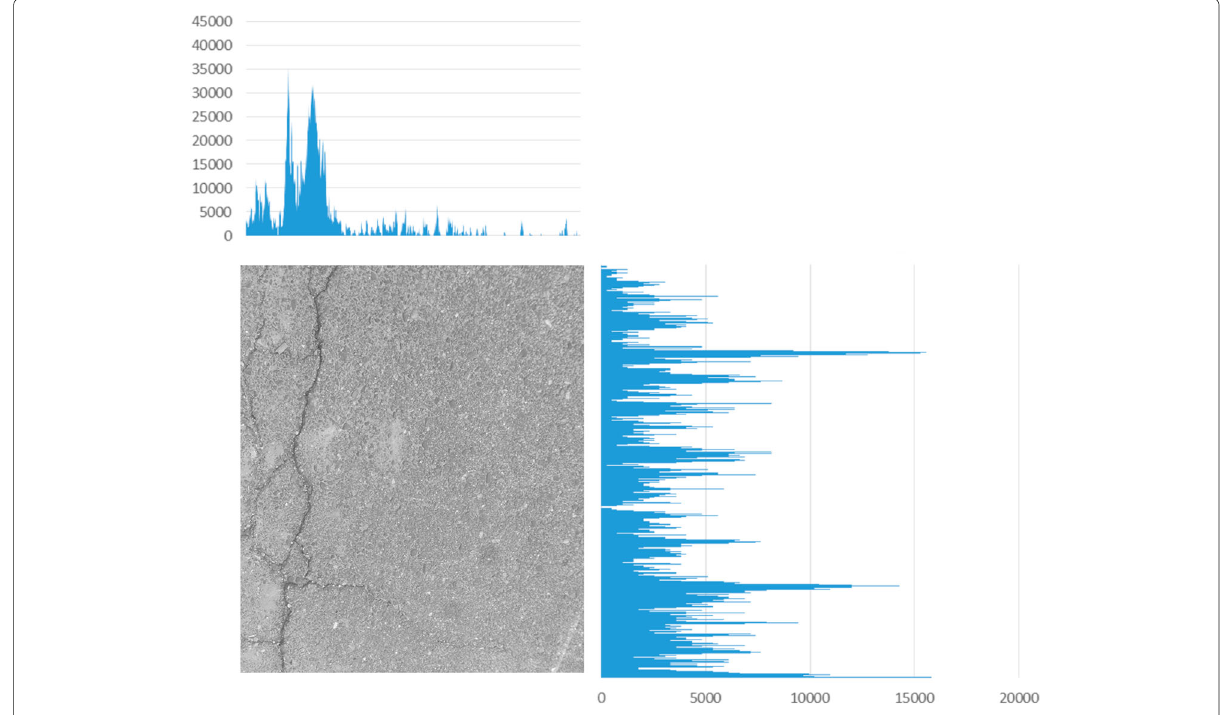
Fig. 8 Horizontal and vertical projective integral